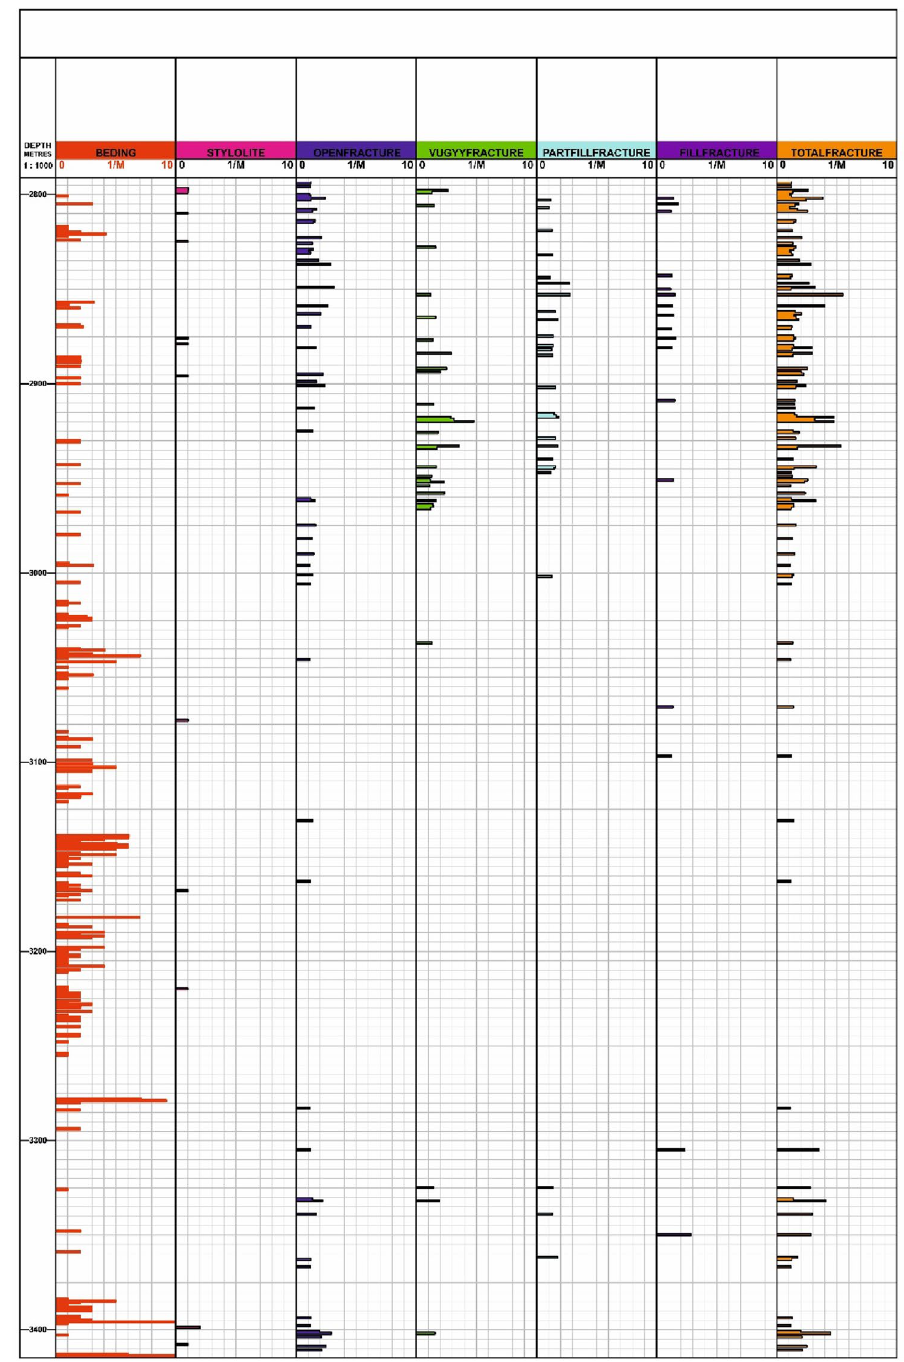
Fig. 9 Density (fractures per 1/M) logs of bedding planes (track 2), stylolites (track 3), open fractures (track 4), vuggy fractures (track 5), partly- filled fractures (track 6), filled fractures (track 7) and total fractures (track